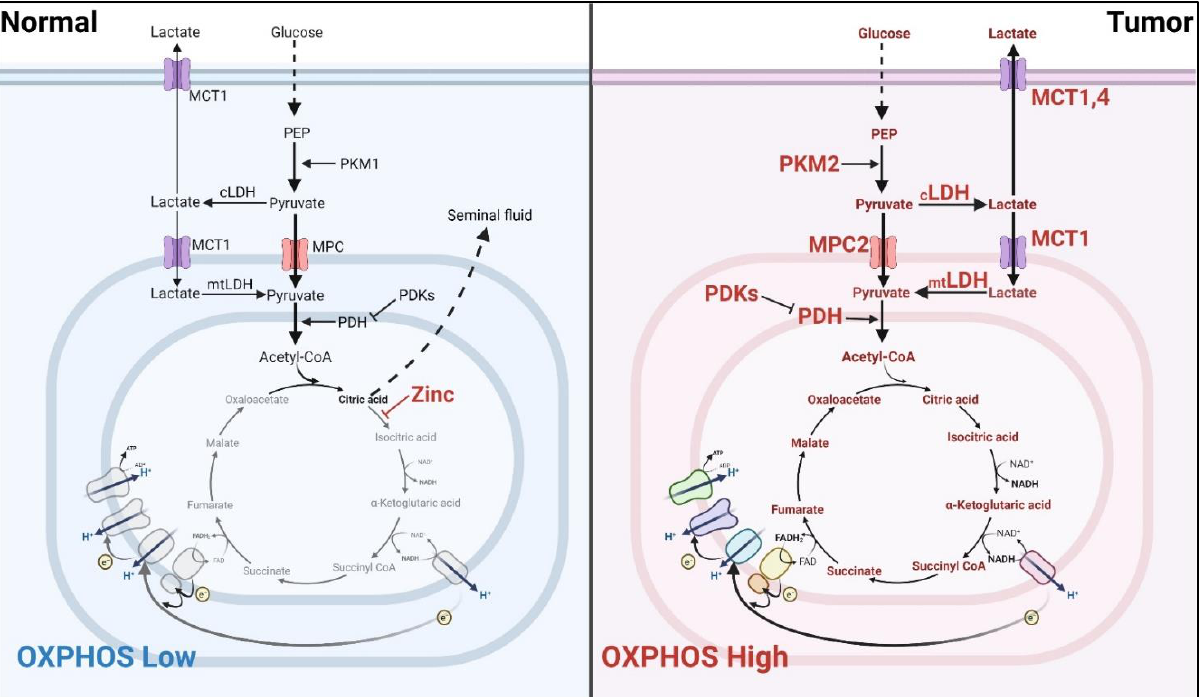
Figure 1. Metabolic switch during prostate tumorigenesis. In normal prostate cells, zinc ion impedes the TCA cycle to release the citrate for seminal fluid production, resulting in the low level of mitochondrial respiration activity (left panel). During the prostate tumor progression, Pca cells overexpress the glycolytic enzymes (including PKM2, MPC2, MCT, mtLDH, PDH, PDKs) to drive the pyruvate flux into the mitochondrial TCA cycle, leading to the high level of mitochondrial respiration activity (right panel).